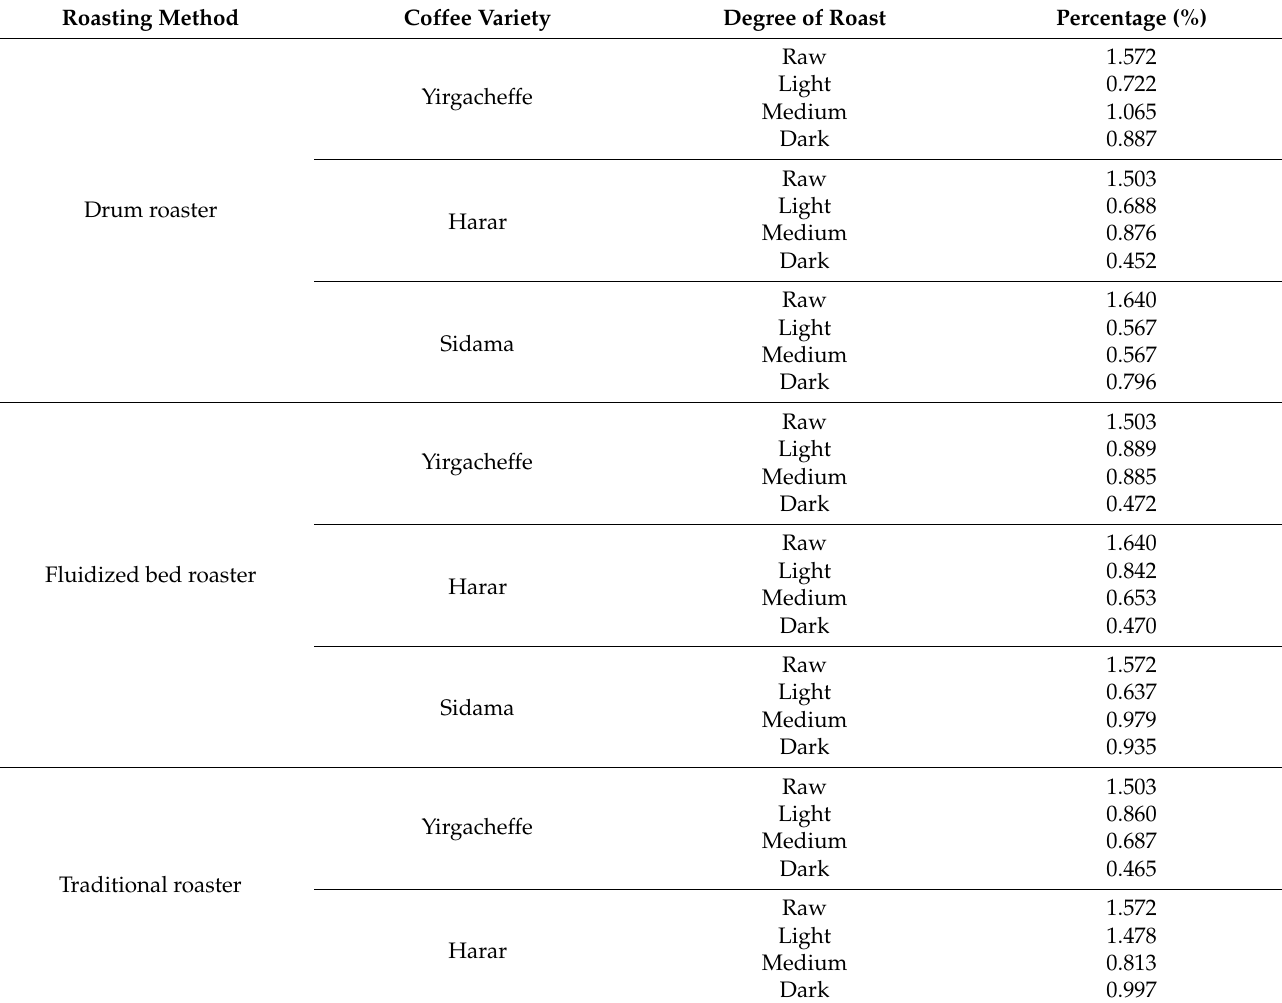
Table 4. Changes in caffeine levels during roasting-process of the various coffees grown in Ethiopia [110]. Roasting Method